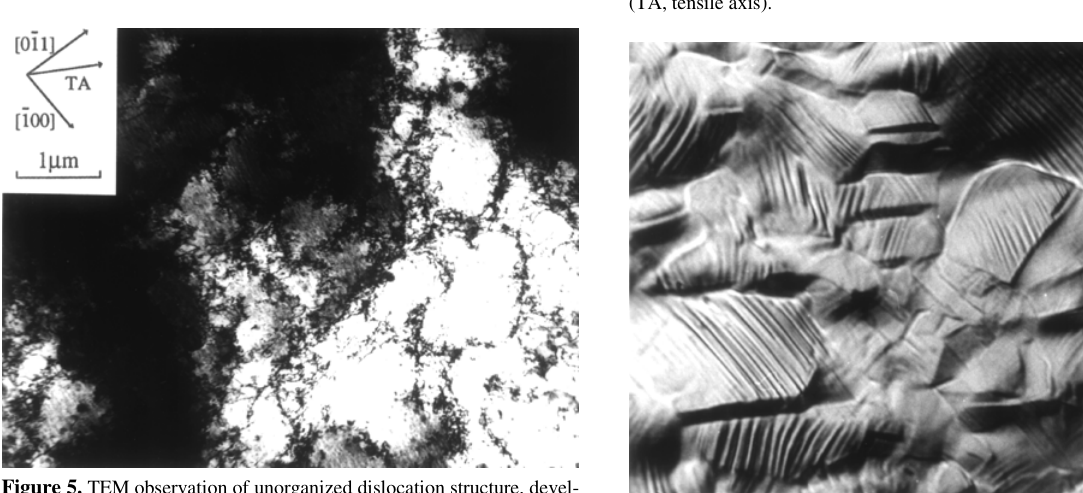
Figure 4. TEM observation of closed parallelogram cells developed in a grain with <1 1 0> axis normal to the sheet plane after a strain amount equal to 0.25 (TA, tensile axis).